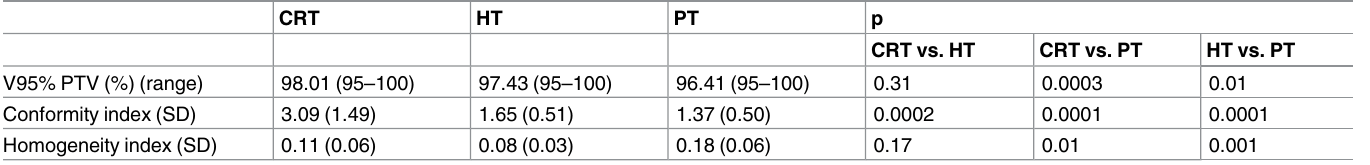
Table 1. Dose to Target volumes.